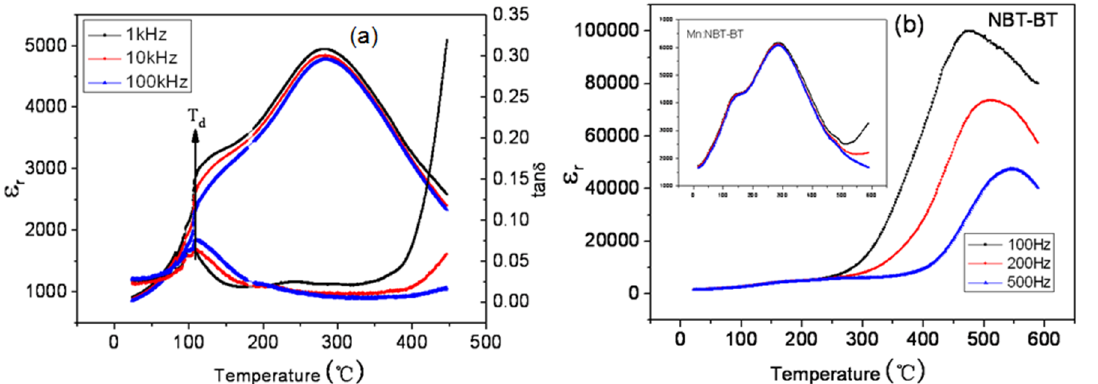
Figure 15. (Color online) Dielectric constant of <001> oriented poled Mn: NBT-BT and NBT-BT crystal samples as a function of temperature. ( a ) Mn:NBT-BT at the frequencies of 1, 10, and 100 kHz; ( b ) Low frequency (100–500 Hz) dielectric constant of Mn:NBT-BT and NBT-BT. Reprinted with permission from [29]. Copyright 2009 AIP Publishing